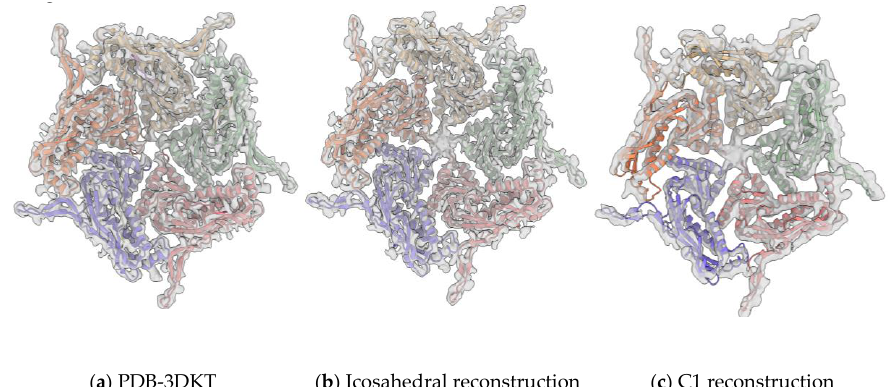
Figure 4. Pores of the heterologous IDM-loaded encapsulin. The inner surface view along the fivefold axis of Encap / IDM complex. From left to right: the X-ray density map of PDB-3DKT ( a ), the crystal model of T. maritima fitted into the icosahedral reconstructed density map of our dataset ( b ), and the C1 symmetry reconstructed map ( c ). Biomolecules 2020 , 10 , x FOR PEER REVIEW